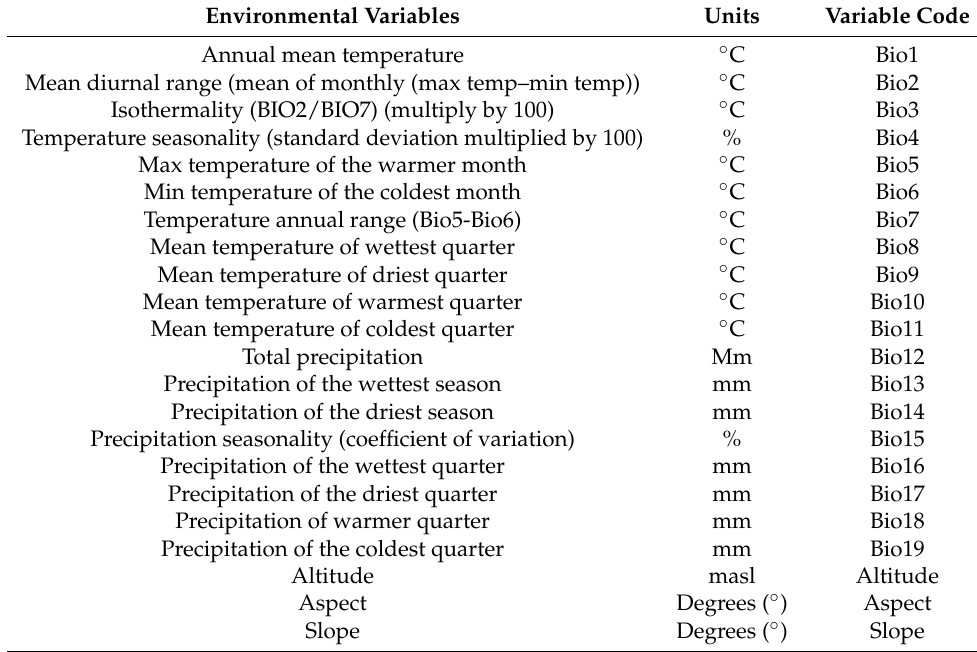
Table 2. Climatic and environmental variables used in this